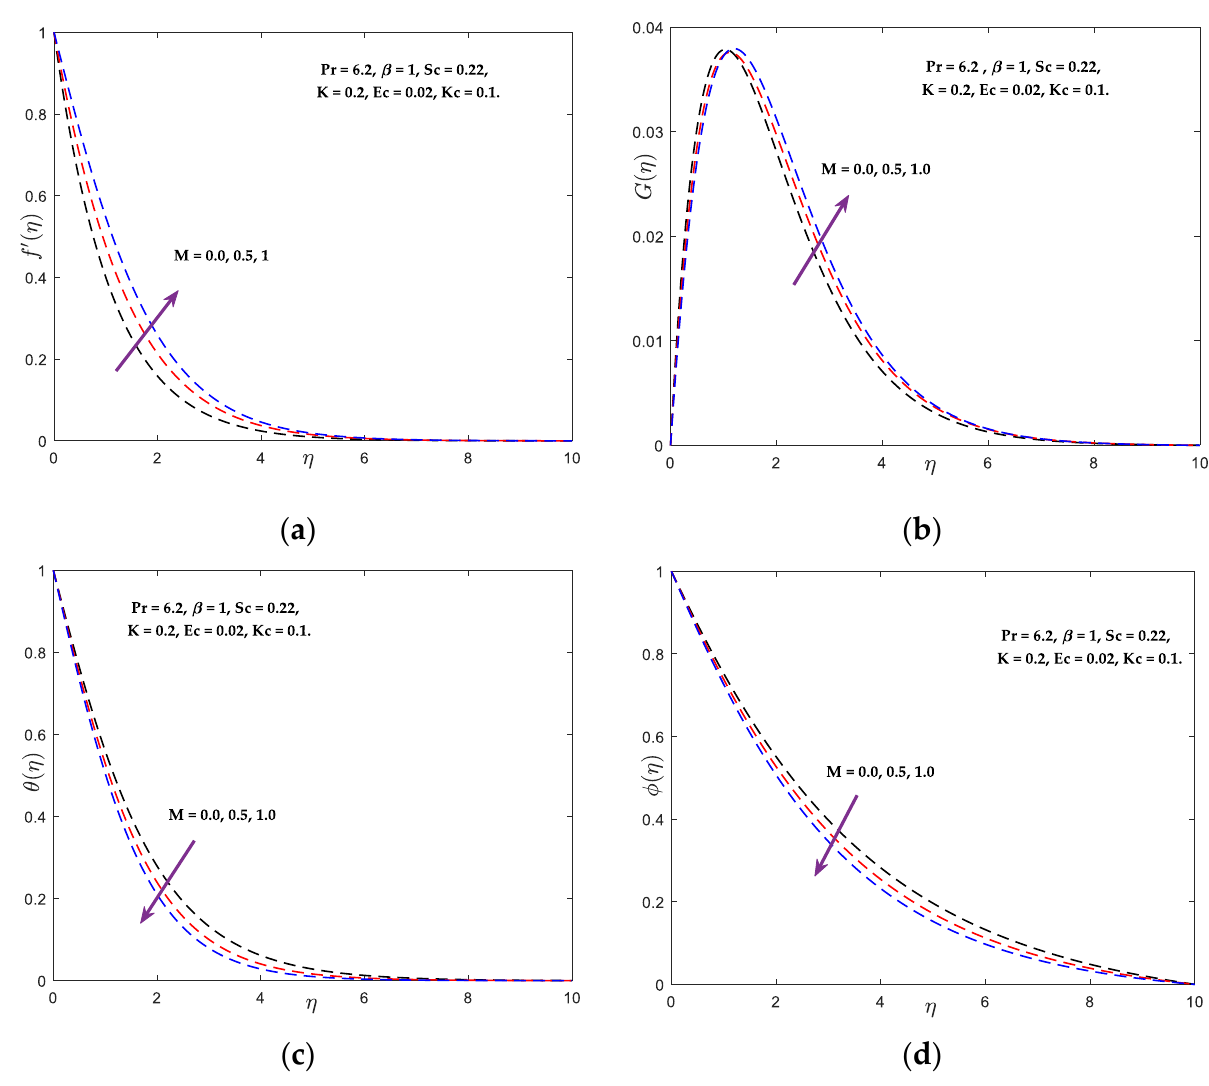
Figure 2. ( a ) Rapidity, ( b ) Angular quickness, ( c ) Temperature, and ( d ) Concentricity vs. 𝑀 . Figure 3a–d outline the substance factor ( K ) on the speed, angular speed, temperature, and concentration distributions. It can be shown that f (cid:48) and g grow with an increase in the quantity of K , whereas opposite phenomena are observed for θ and φ . Normally, when the fluid consistency diminishes, the added substance’s angular velocity enhances. The temperature outlines are displayed in Figure 4 for diverse amounts of the Prandtl quantity ( Pr ). It is found that expanding the values of Pr (beginning with water Pr = 6.2) diminishes the temperature outline. The behaviour of the Prandtl number is determined by the interaction between the velocity diffusion process and the thermal boundary surface. Due to the dominance of the viscous diffusion over the thermal diffusion, the Prandtl number rises. Therefore, the existence of the Prandtl number ( Pr ) causes a reduction in the thermal boundary layer thickness distribution. In continuum mechanics, the Eckert number ( Ec ) is dimensionless. It characterises heat transfer dissipation by expressing the link between a flow’s kinetic energy and the boundary layer enthalpy differential. The Eckert number quantifies the flow’s kinetic energy concerning the enthalpy differential across the thermal boundary layer. It is used to characterise heat dissipation in high-